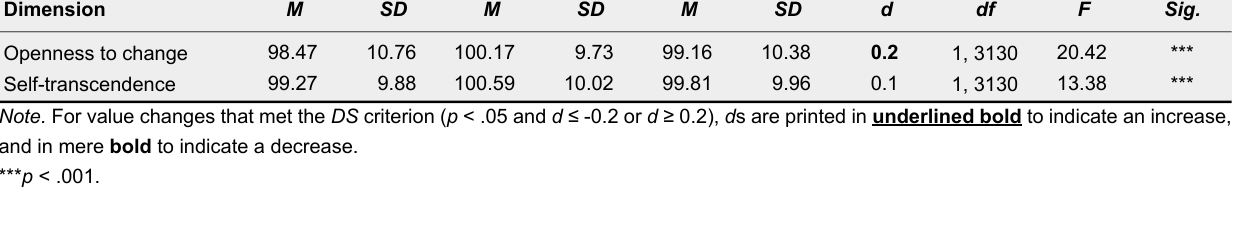
ANOVA Total ( N = 3132)2015 ( n = 1287)1991 ( n = 1845) d ***1, 3130Openness to change .4220 .20 .3810.1699.739.17100.7610.4798 ***1, 3130Self-transcendence .3813.10.969.8199.0210.59100.889.2799